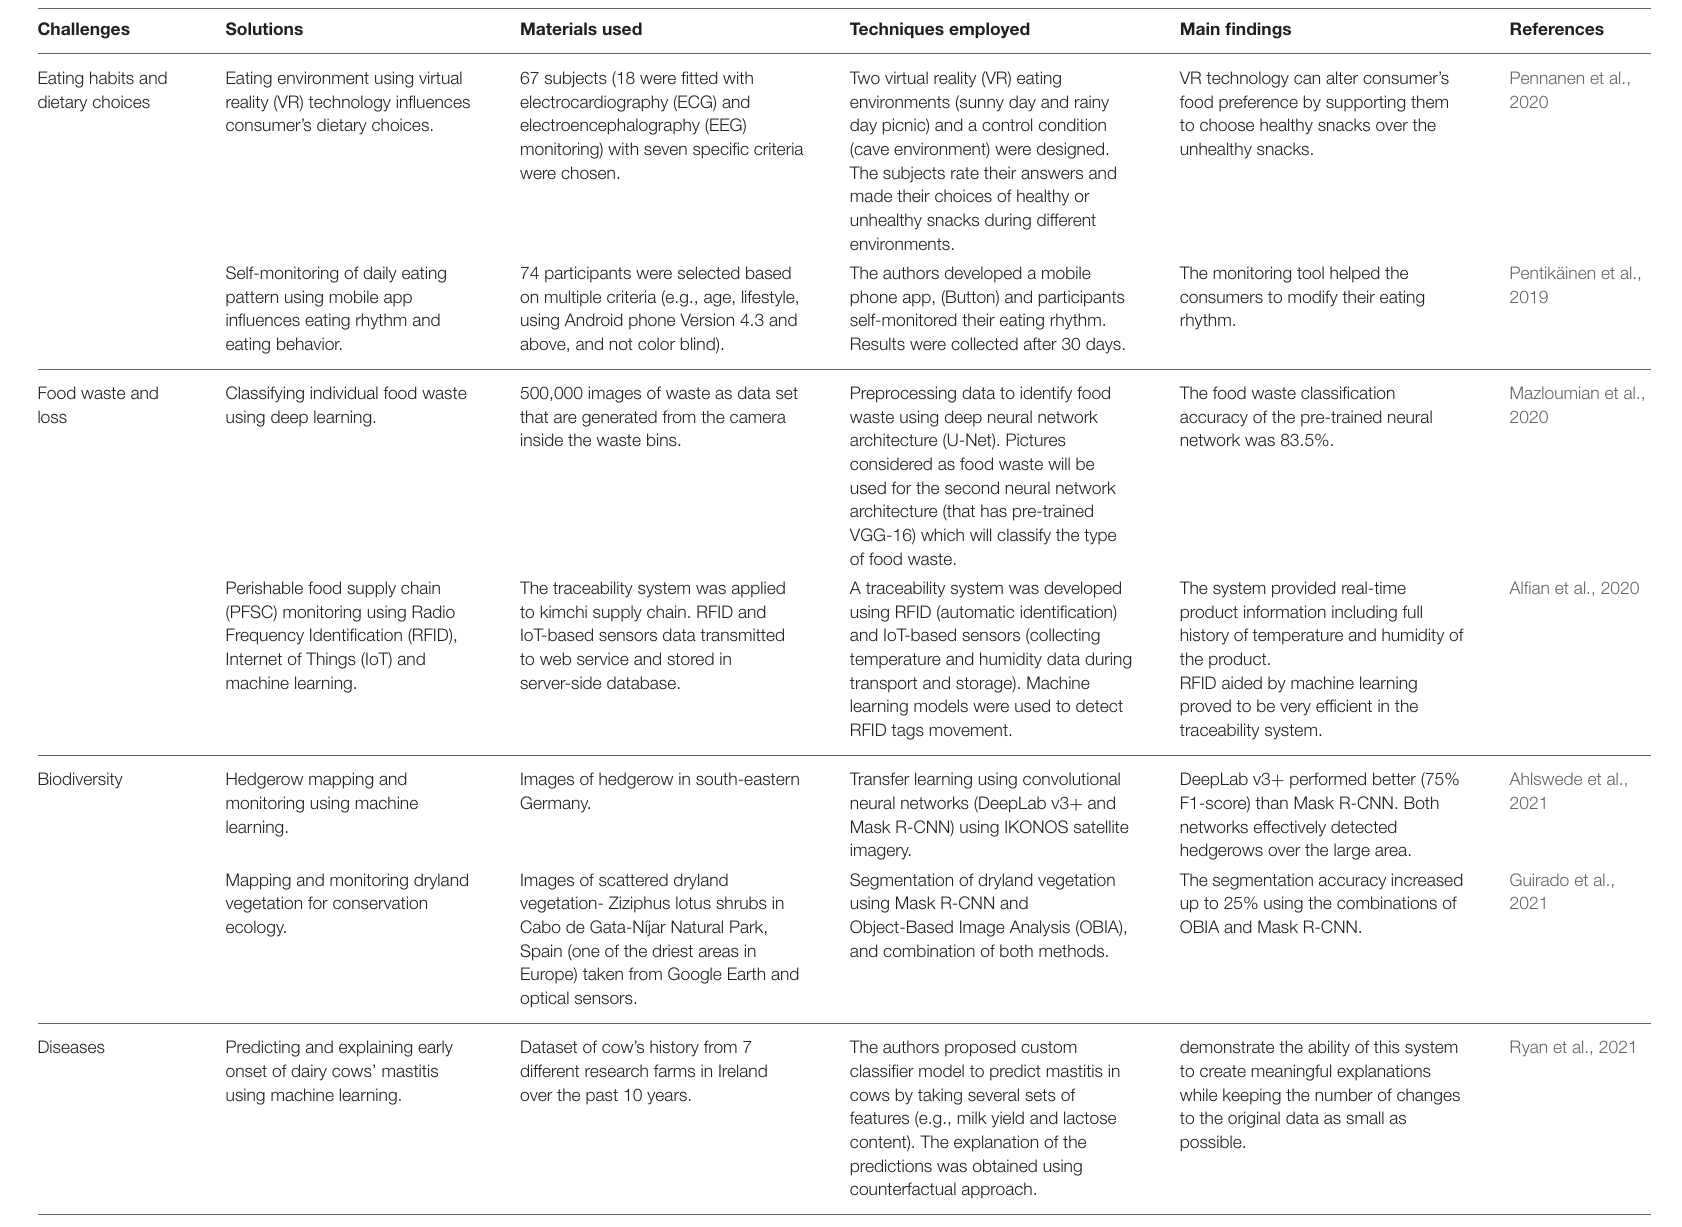
TABLE 4 | Recent research advances in digitalization solutions to overcome challenges in global food